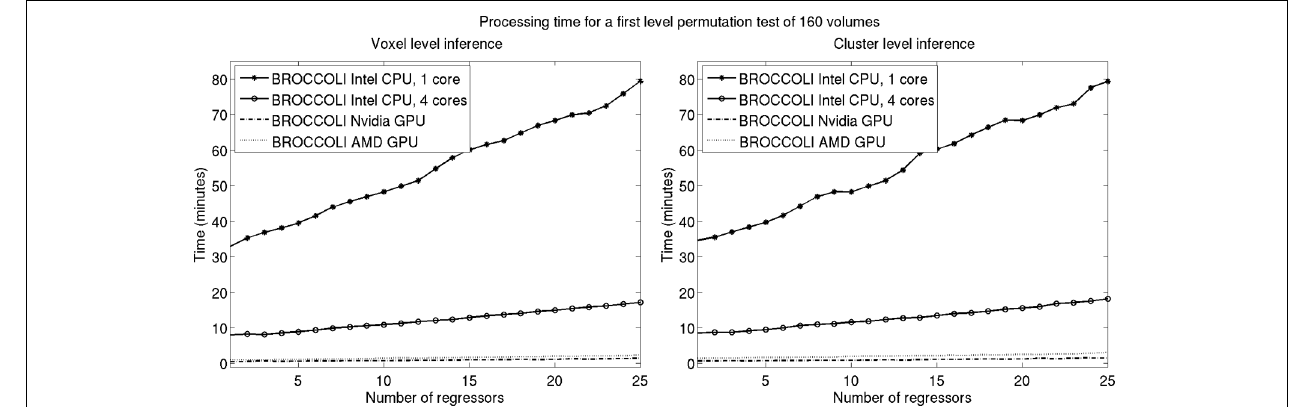
FIGURE 11 | Processing times for BROCCOLI for first level analysis using a permutation based t -test with 10,000 permutations (SPM, FSL, and AFNI do not provide any functions for first level permutation based analysis). Left: Voxel-level inference, the maximum t -test value is saved in each permutation. Right: Cluster-level inference, the extent of the largest cluster is saved in each permutation. A t -value of 3 was used as a cluster defining threshold. The data used is of the size 64 × 64 × 33 × 160. A brain